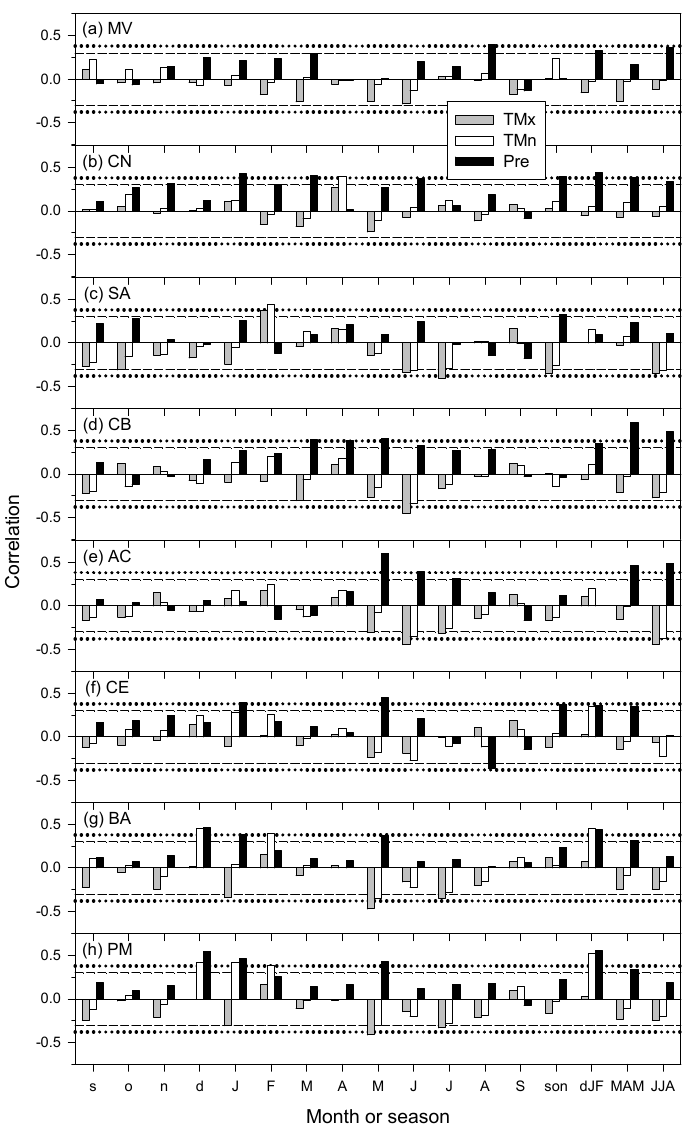
Figure 2. Climate–growth relationships assessed in eight Atlas cedar plantations (( a ), MV, Valliguières; ( b ), CN, Berriozar; ( c ), SA, Sariñena; ( d ) CB, Bañón; ( e ) AC, Monte Abantos; ( f ) CE, Monte Mario-Béjar; ( g ) BA, Baza; and ( h ) PM, Puerto de la Mora). Bars show the Pearson correlations calculated by relating monthly or seasonal climate data (mean maximum—TMx—and minimum— TMn—temperatures, total precipitation—Pre) and sites’ mean series of ring-width indices. Correlations were calculated from prior to current September and months abbreviated by lowercase and uppercase letters correspond to the previous and current years, respectively. Horizontal dashed and dotted lines indicate the 0.05 and 0.01 significance levels, respectively.